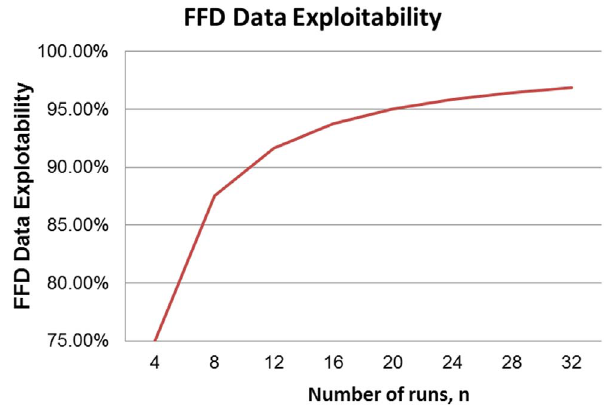
Figure 2. Exploitability performance in terms of increasing number of runs.